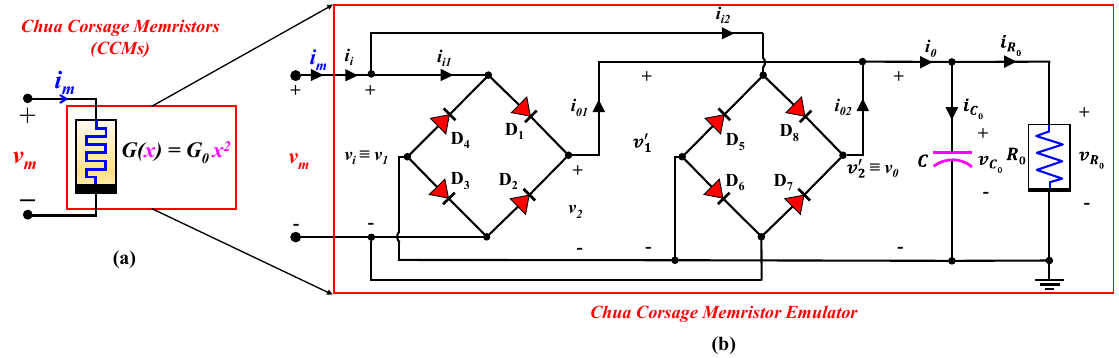
Figure 8. Circuit diagram of ( a ) Chua corsage memristors and ( b ) Chua corsage memristor emulators with bi-stability or multi-stability input dynamics.